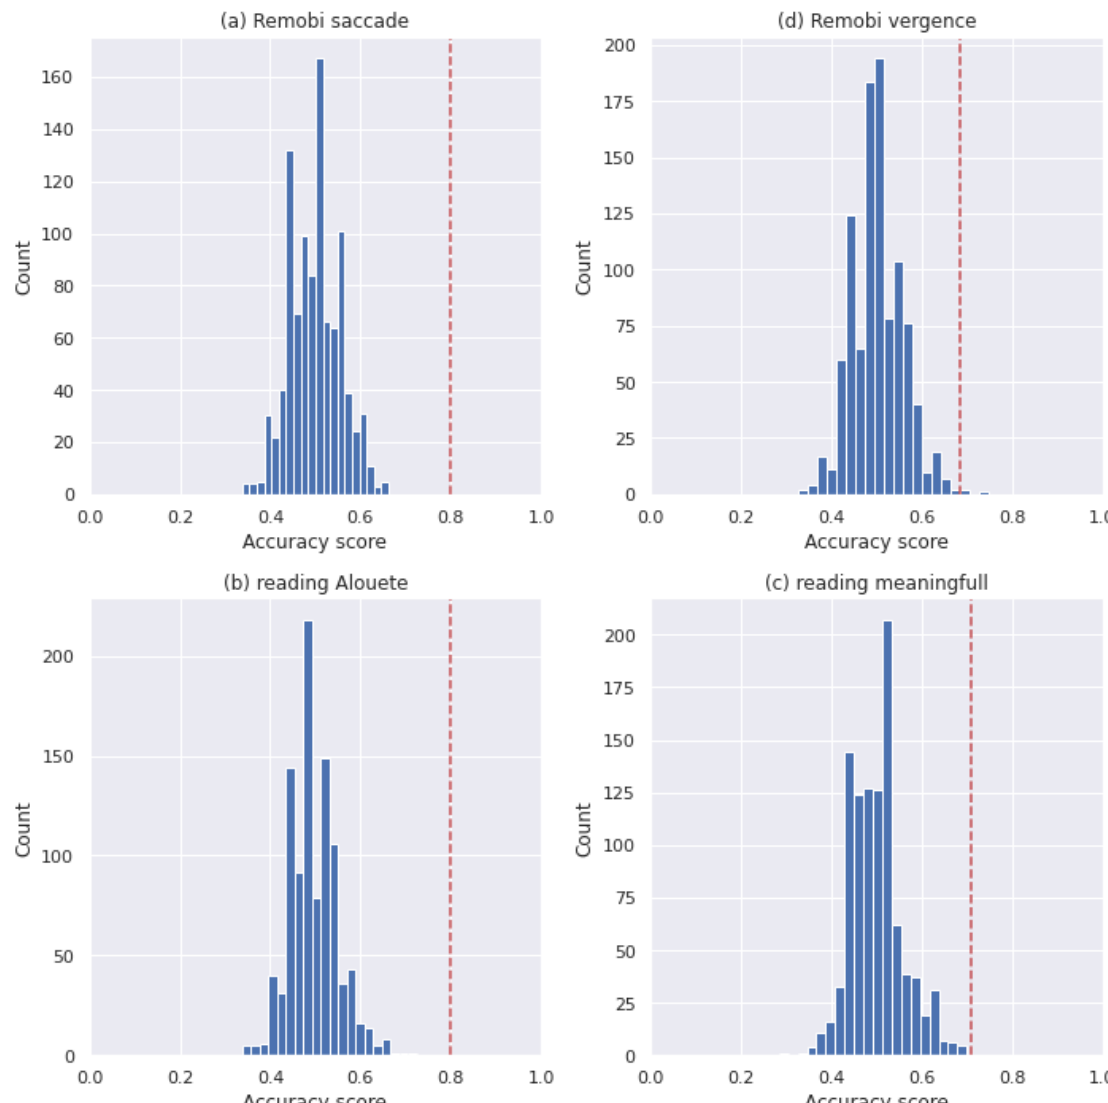
Figure 3. SVM test permutation histograms for Analysis 1; the red line indicates the reported score. ( a ) The histogram of the Remobi saccade dataset, ( b ) the histogram of the Remobi vergence dataset, ( c ) the histogram of the reading Alouette, ( d ) the histogram of the reading meaningful.